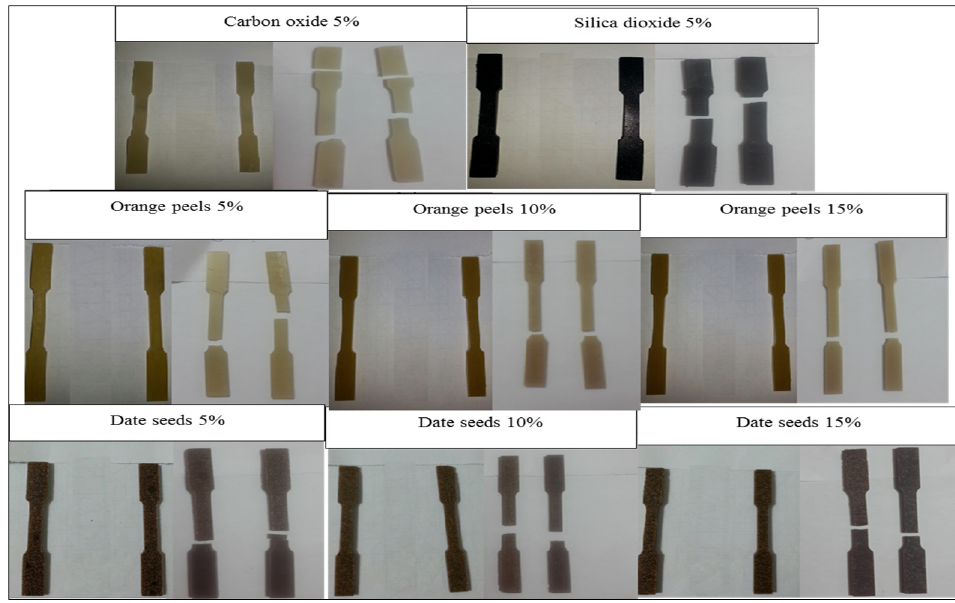
Fig. 2. Section of tensile test specimen .